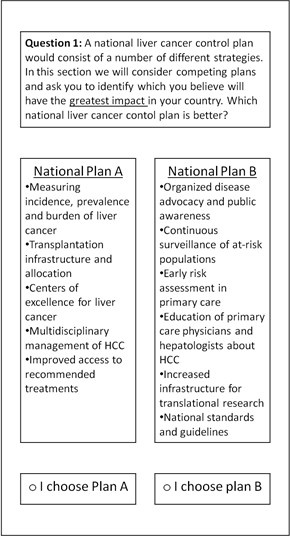
An example of a conjoint analysis choice task
.